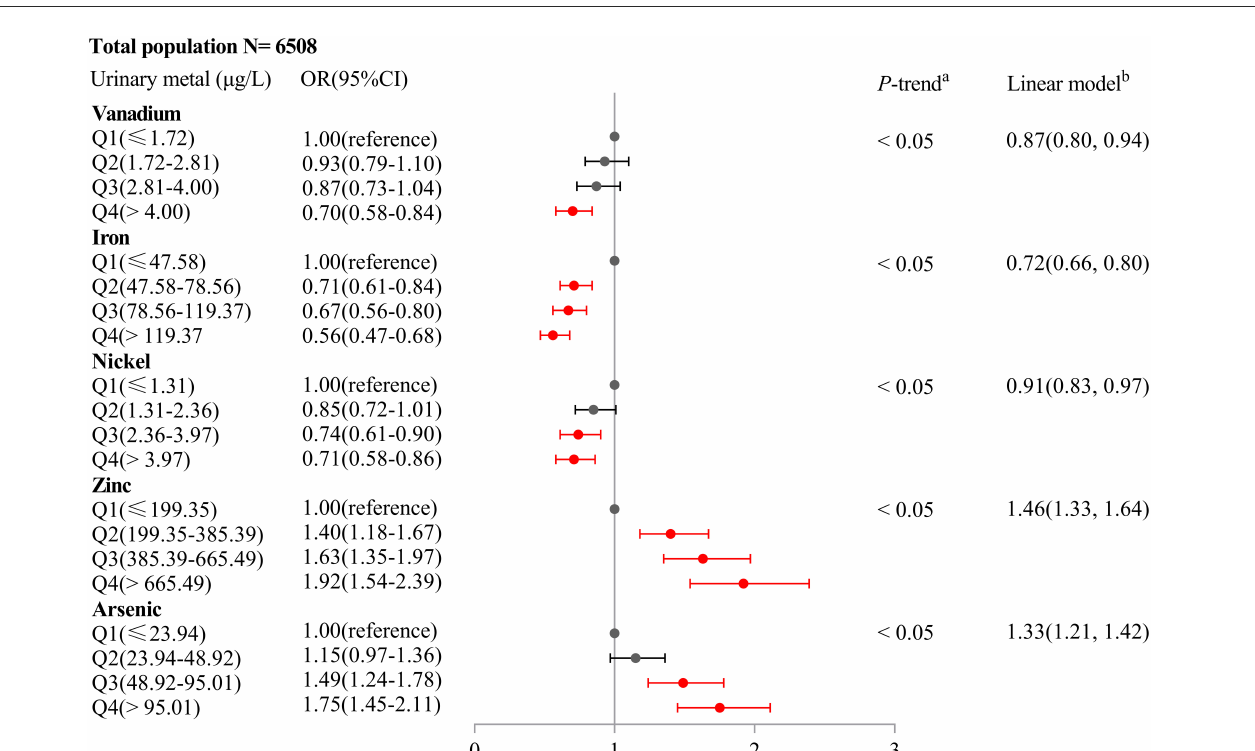
revealed the correlations among 21 metals with each other (all P < 0.05), wherein Se showed a strong correlation with titanium, Zn, As, rubidium, and Mo (the corresponding correlation coefficients: 0.76, 0.71, 0.76, 0.74, and 0.74, all P < 0.05). However, the correlation of V with Al was weak (correlation coefficient: 0.13, P <